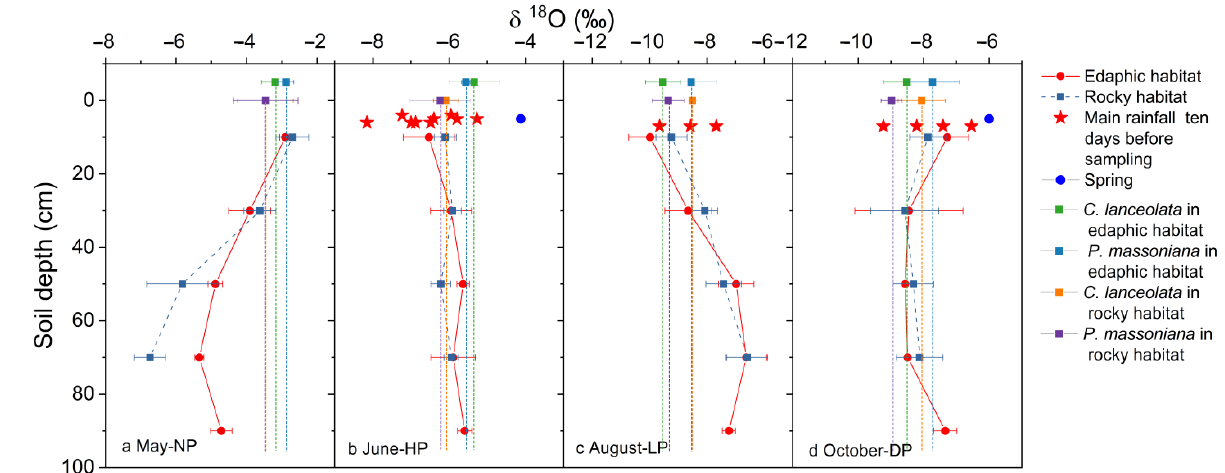
October sampling).